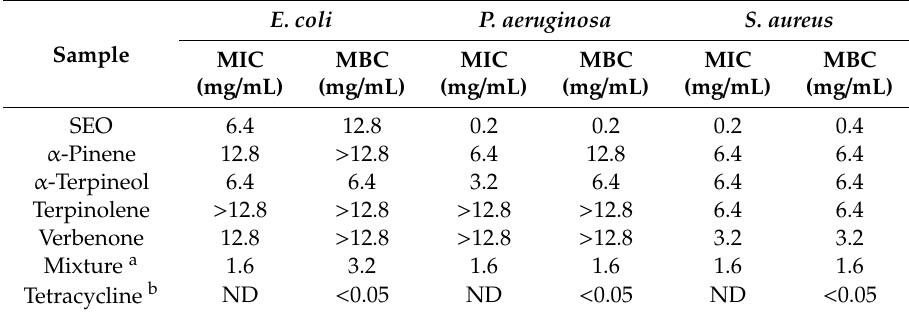
Table 3. Antibacterial activities of SEO and the main monomers.